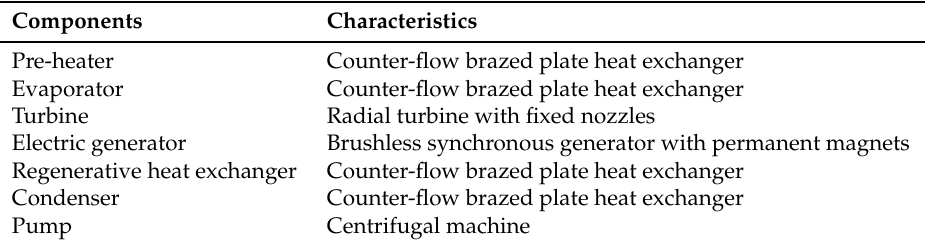
Table 2. Devices of the ORC module.